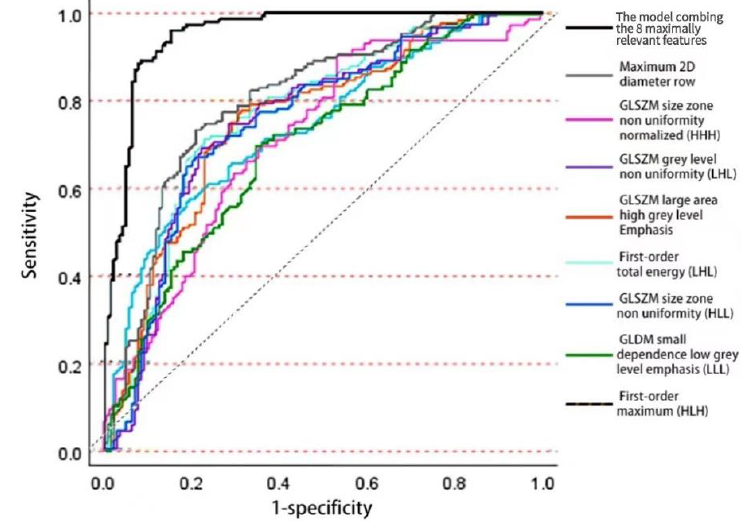
Figure 3. ROC curves of individual radiomic features and the logistic regression model of 8 selected features for identifying hepatocellular carcinoma (HCC) metastasis on the training set.